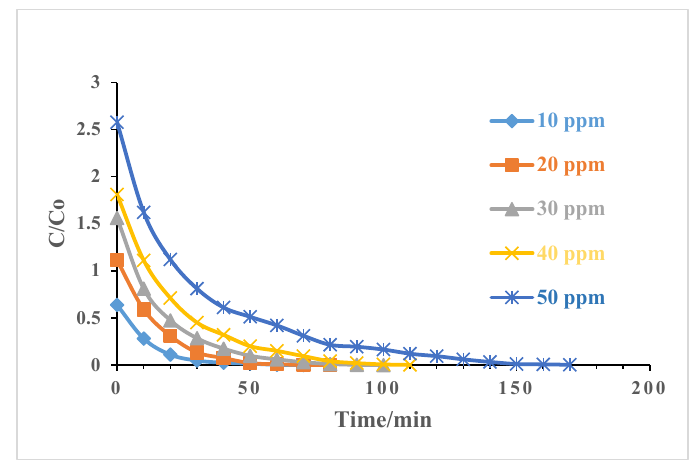
Fig. 8. Effect of dye solution on degradation using FeCr